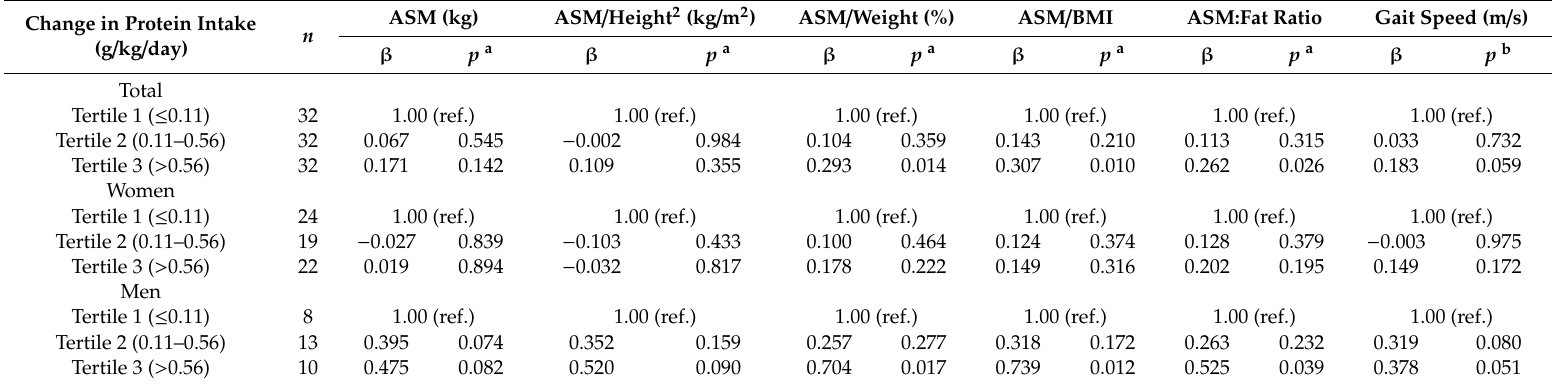
Table 4. Multiple linear regression analysis of changes in muscle mass and gait speed according to tertiles of change in protein intake based on the distribution of total older